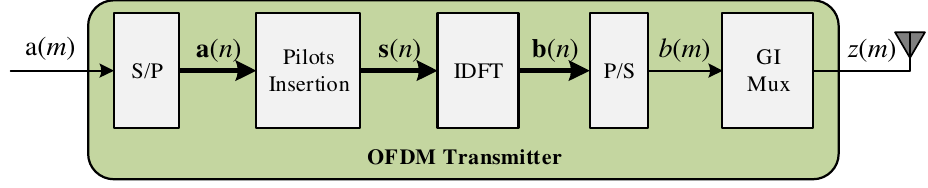
Figure 2. Illustration of the discrete baseband OFDM transmitter. S/P, Serial-to-Parallel converter; IDFT, Inverse Discrete Fourier Transform; P/S, Parallel-to-Serial converter; GI, Guard